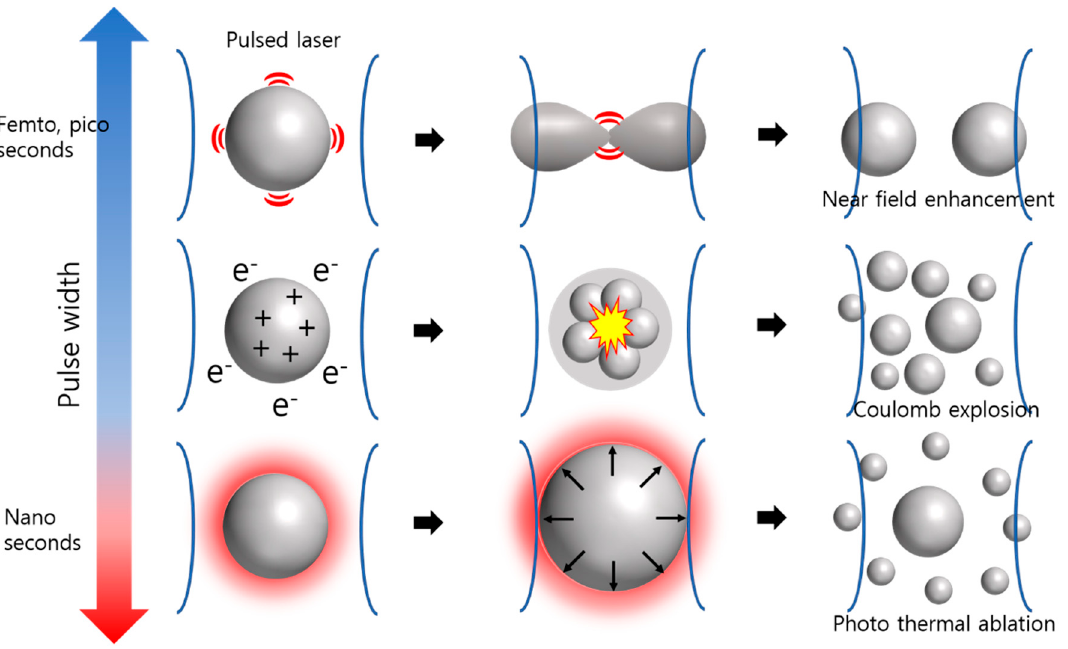
Figure 1. Mechanisms causing laser fragmentation for different laser pulse widths.